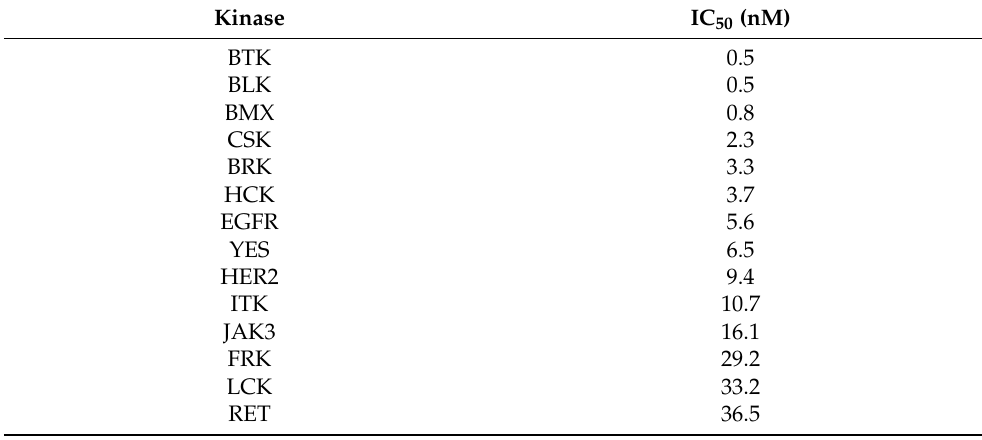
Table 1. Kinases prone to the inhibition by